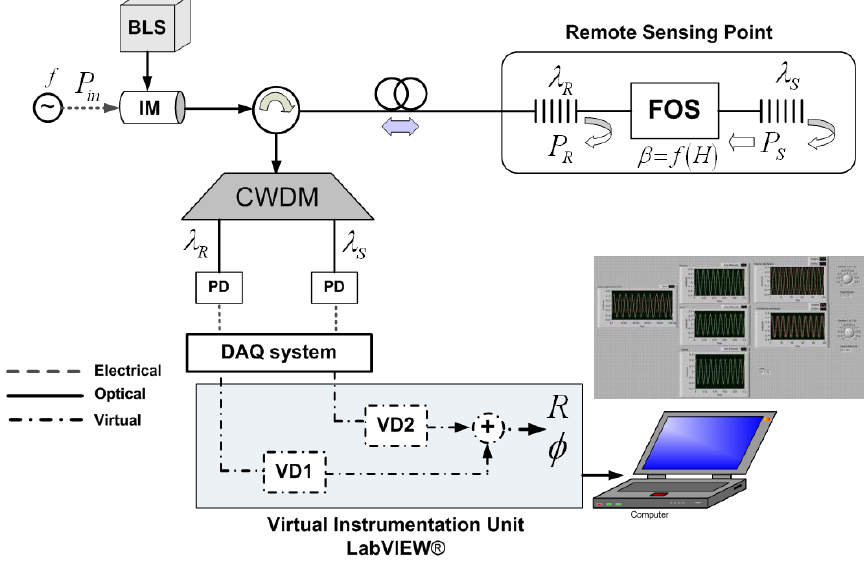
Figure 2. Experimental setup. Inset: user graphical interface for Φ parameter. BLS: Broadband Light Source, IM: Intensity Modulator, PD: